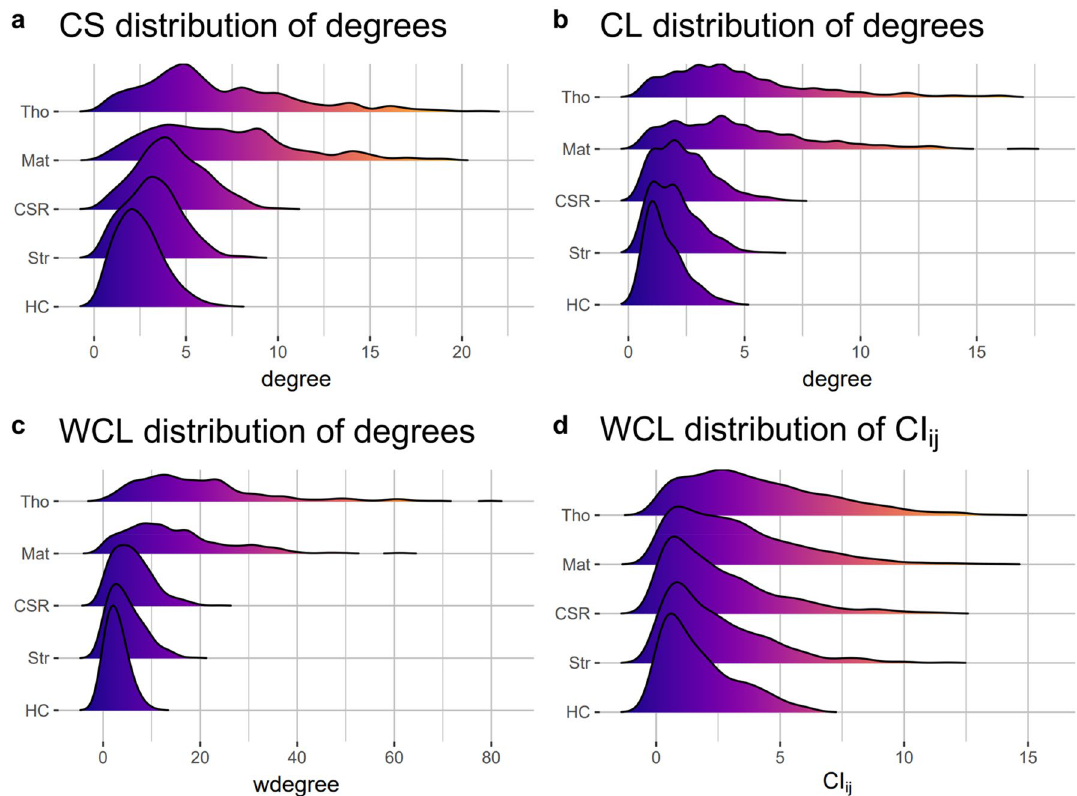
Figure 4. Node degree distribution and edge distribution of the network (with individual trees as nodes). ( a , b ) The node degree distribution of CS and CL networks based on five spatial null models. ( c ) The weighted degree distribution of WCL. ( d ) Distribution of edge weight (namely CI) in WCL.